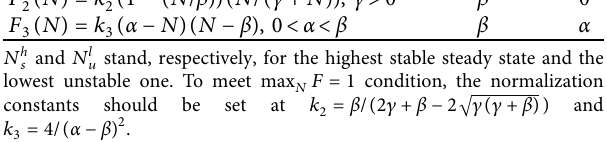
Table 2: Interspecific models of sterile-fertile competition. H ( N ) Submodel H Holling type-III H ( N ) � 1/ s Flat mating IV